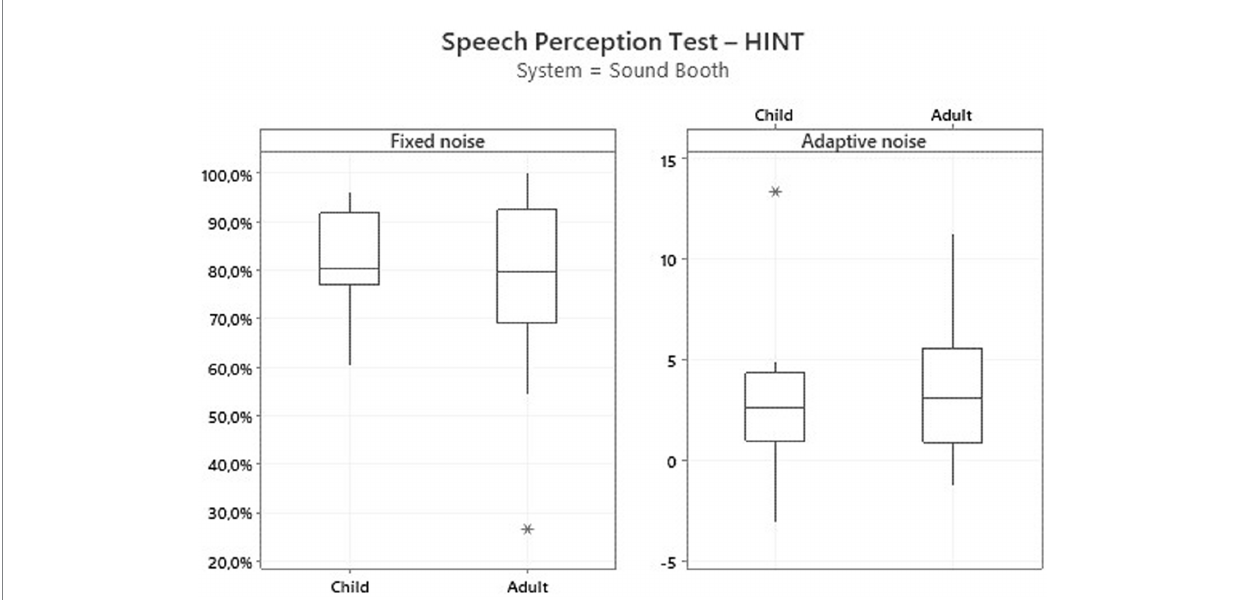
FIGURE 3 Thresholds for the PTA assessment in the SB. The results were not statistically significant at all frequencies evaluated. The box plot represents the 25th and 75th percentiles (box boundaries) and medians (horizontal lines). Outliers are indicated with asterisks.